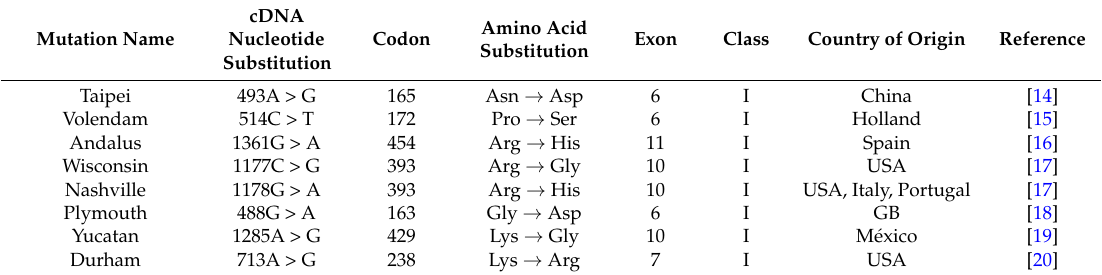
Table 1. Main data about G6PD variants characterization previously reported.